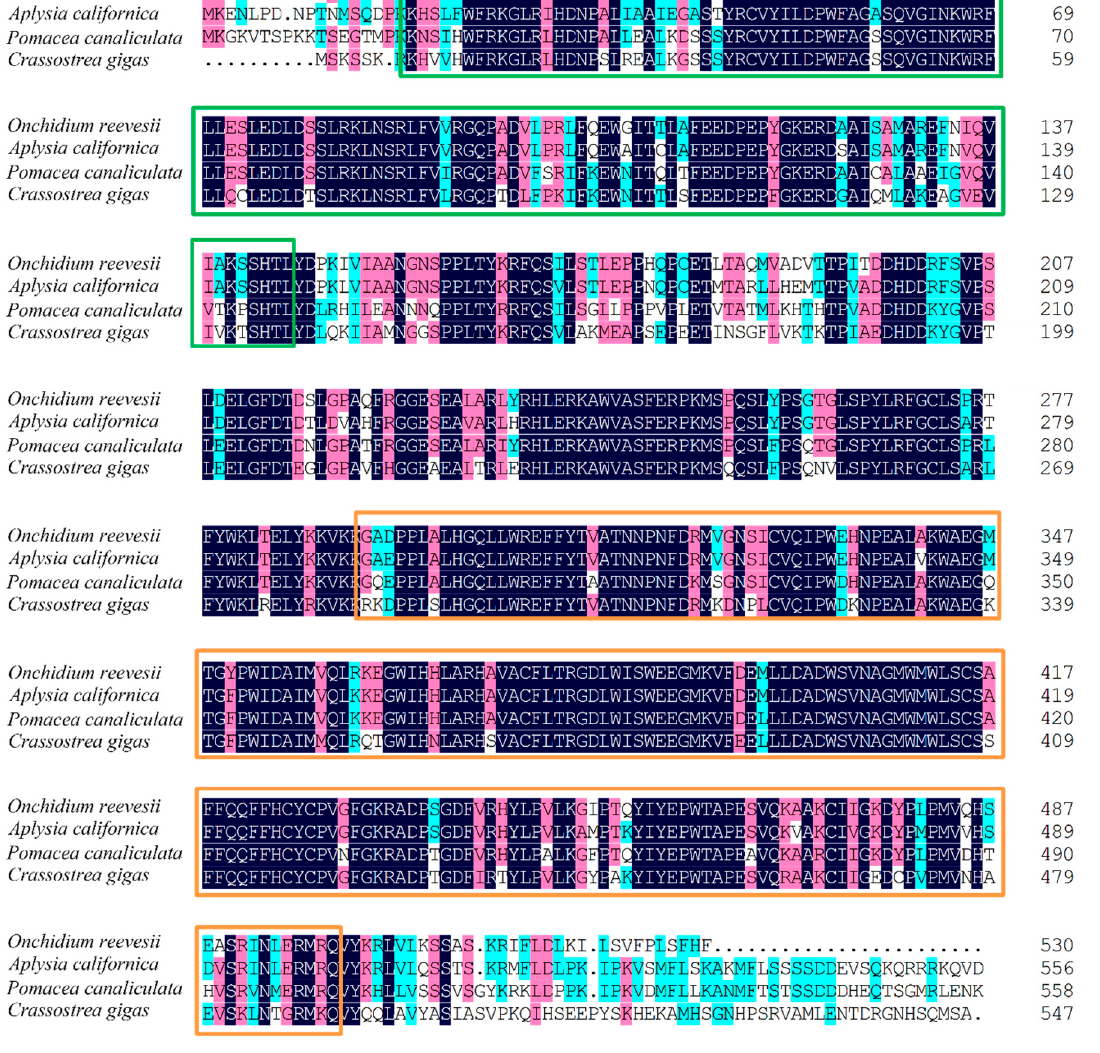
Figure 4. Alignment of conserved regions for CRY1. The Onchidium CRY1 protein contained conserved domains present in orthologs for Aplysia, Pomacea, and Crassostrea: green frame indicates the PHR domain and orange frame indicates the FAD binding domain. The blue shading indicates identical residue, pink shading indicates residues with strongly similar properties, and the cyan shading indicates residues with weakly similar properties.